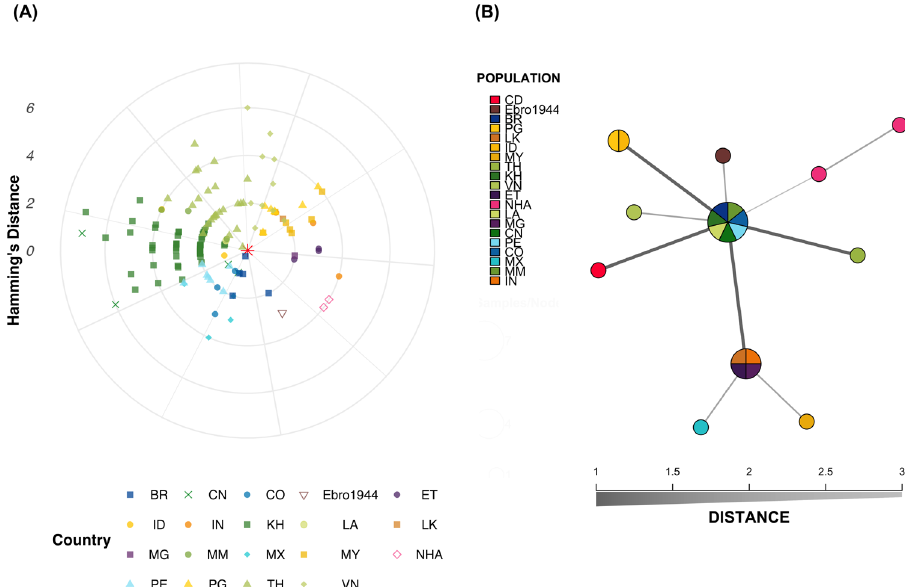
Fig. 5 P. vivax mitochondrial Hamming ’ s distances and minimum-spanning network. Comparison of DRC P. vivax with over 700 globally sourced P. vivax isolates yielded 142 within-country unique consensus haplotypes and 102 overall unique consensus haplotypes, as duplicates existed within countries. In the instance of the DRC consensus haplotypes ( n = 2/3), one isolate was identical except for ten missing sites. As a result, the two DRC consensus haplotypes were reduced to a single sequence and used in the above fi gures. A The DRC consensus haplotype is depicted in the center (red asterisk) and orbited by the other 140 consensus haplotypes. Distances from the center are determined by the number of base-pair differences while the relative position along the orbit is arbitrary and clustered only for visualization aid. Isolates from the Americas are colored in shades of blue and include Brazil (BR), Colombia (CO), Mexico (MX), and Peru (PE) Isolates from Asia are indicated in shades of yellow – green and include China (CN), Indonesia (ID), Cambodia (KH), Laos (LA), Myanmar (MM), Malaysia (MY), Papua New Guinea (PG), Thailand (TH), and Vietnam (VN). India (IN) and Sri Lanka (LK) are indicated in shades of orange, while Ethiopia (ET) and Madagascar (MG) are indicated in shades of purple. Finally, the Democratic Republic of the Congo (DRC) is shown in red and non-human apes (NHA) are shown in magenta. The historical sample from the Ebro Delta in Spain dating to 1944 (Ebro1944) is colored in brown. B A representative consensus haplotype from each country and both unique non-human ape sequences were selected as input into the minimum-spanning tree. Overall, there are similarities among the haplotypes from both the Americas and Asia, as well as the DRC consensus haplotype, although to a lesser degree. In terms of base-pair differences (Hamming ’ s distance), the DRC mitochondrial consensus haplotype differed by three and four bases to the Ebro1944 and the non-human ape consensus haplotypes, respectively. All unique consensus haplotypes with respect to country of origin are provided for comparison and context (Supplementary Fig.